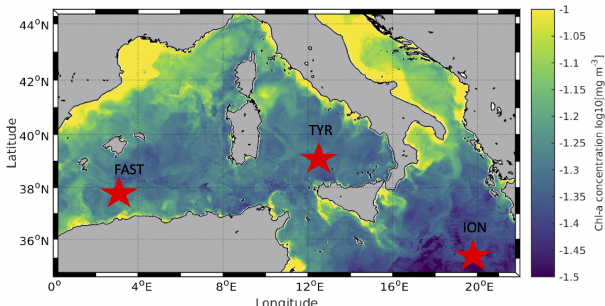
Figure 1. Location of the sampling stations in the Mediterranean Sea on board the R/V Pourquoi Pas? during the PEACETIME cruise. Background shows satellite-derived surface chlorophyll a concentration averaged over the entire duration of the cruise (cour- tesy of Louise